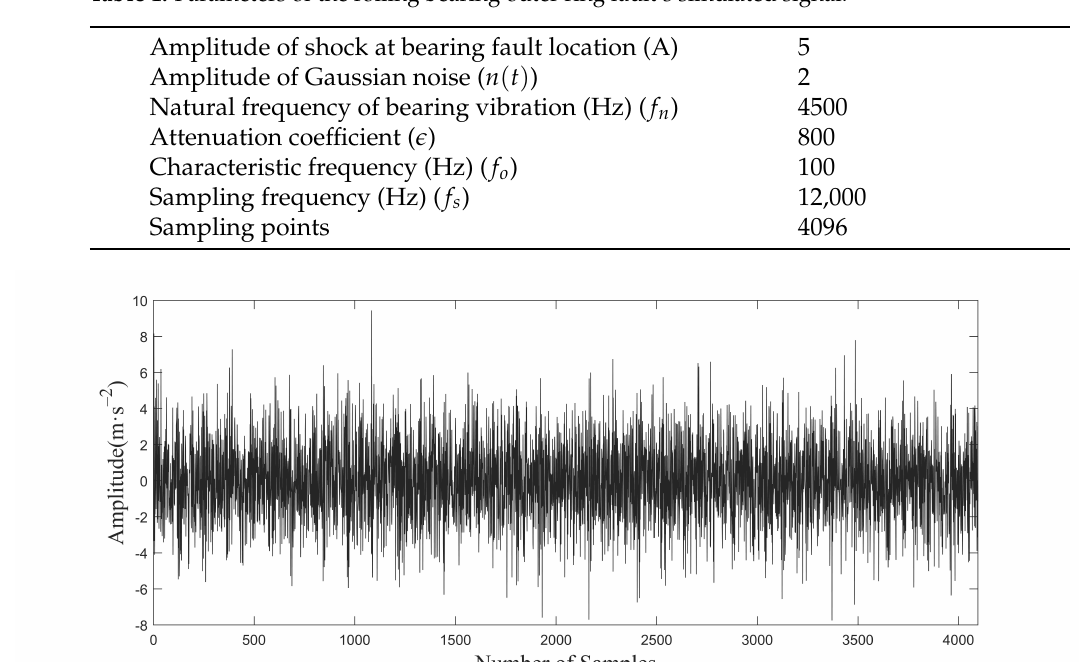
Table 1. Parameters of the rolling bearing outer ring fault’s simulated signal.